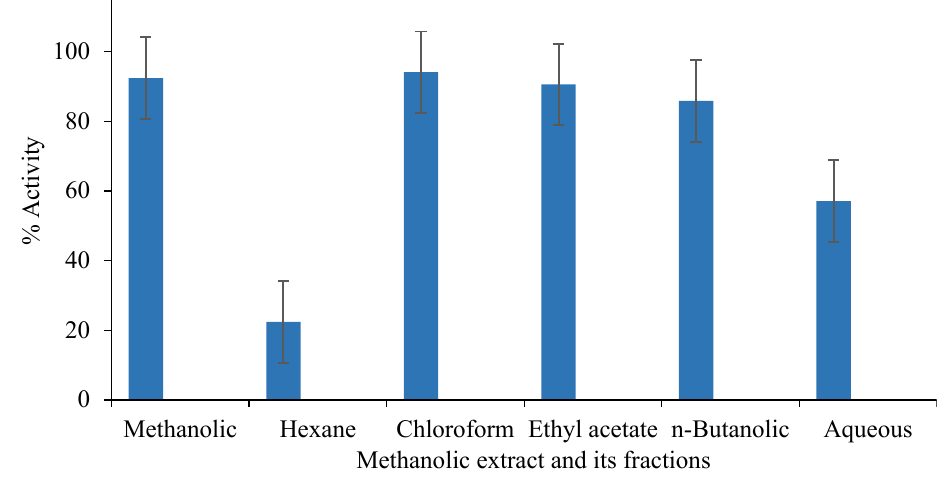
Figure 2. ABTS radical scavenging activity methanolic extract of Carissa opaca roots